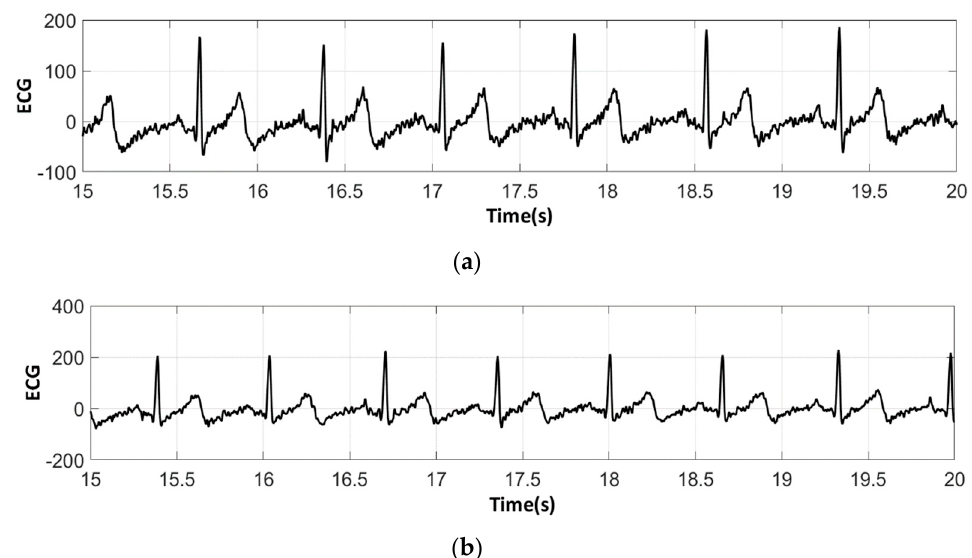
Figure 19. ECG signal obtained by silver-plated electrodes: ( a ) before washing; ( b ) after 50 washing cycles.